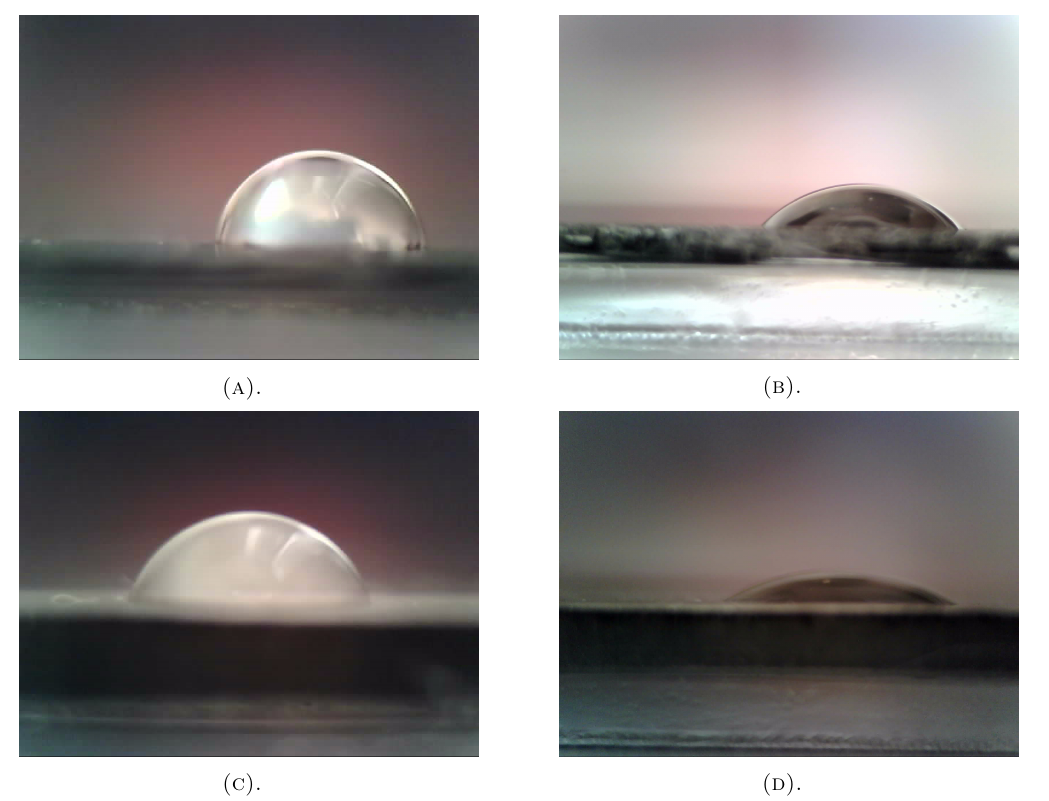
Figure 2. Water drop contact angle of SC-Si(100) (top) and SC-ss (bottom) before (left) and after treatment at 300